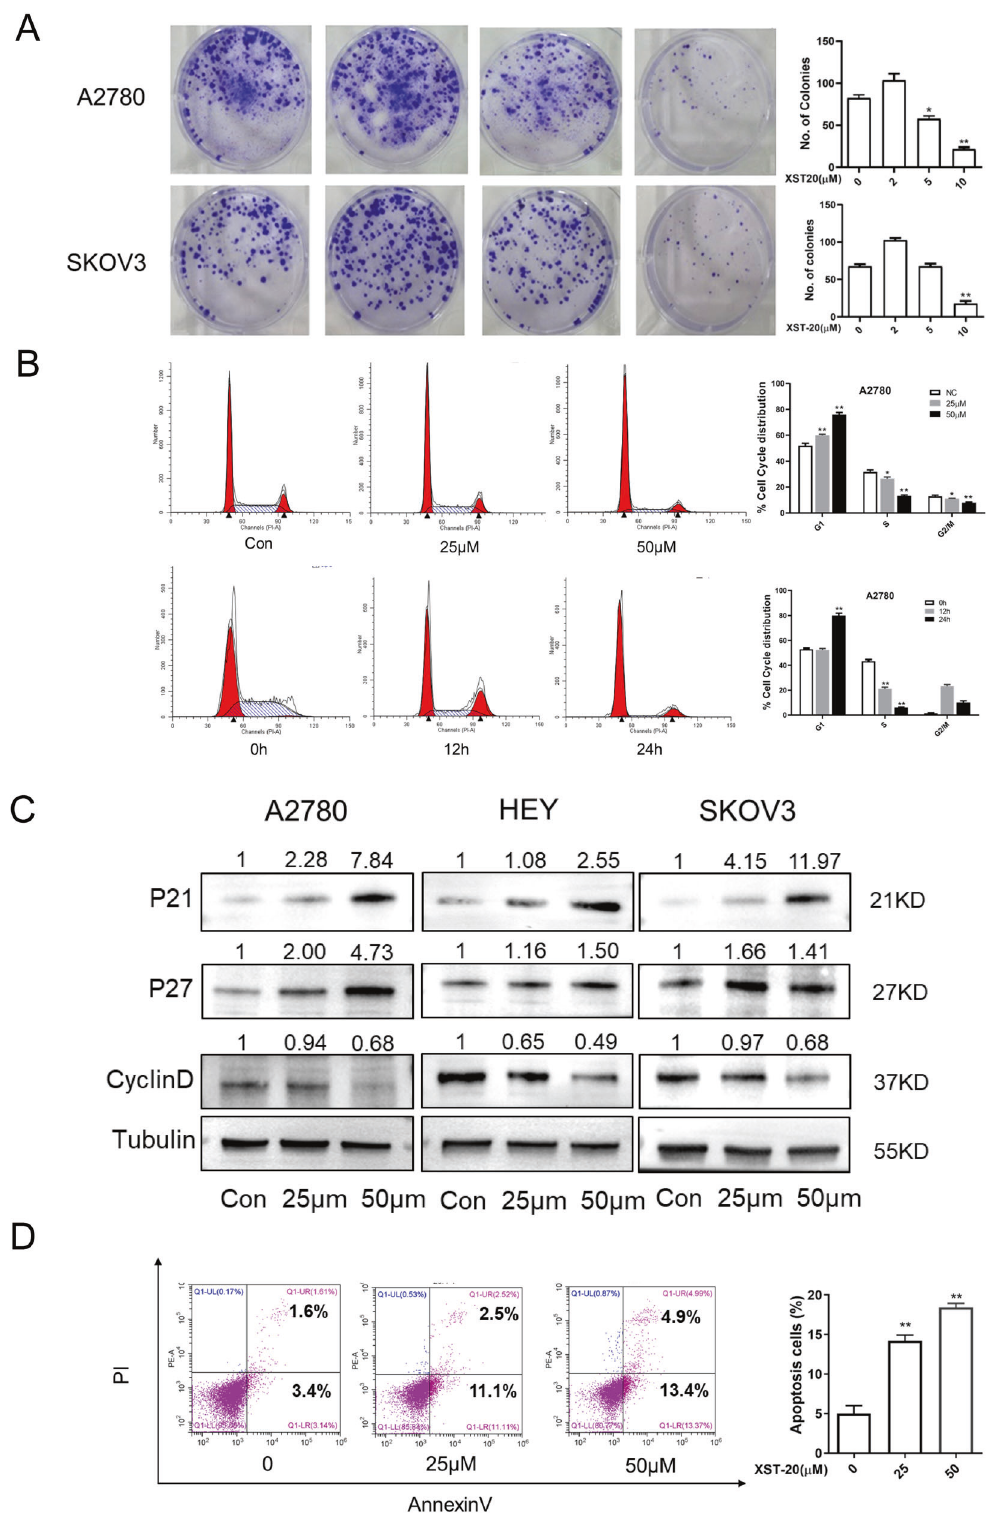
Fig. 5 XST-20 exhibits an anti-tumor effect in ovarian cancer cells. A Clonogenic assay were conducted to measure the inhibitor effect of XST-20 on ovarian cancer cells. B Cell cycle distribution was examined by fl ow cytometry in A2780 cells treated with XST-20. C Proteins that are involved in the regulation of G1/S progression were analyzed by western blot in A2780, HEY, and SKOV3 cells treated with XST-20. D A2780 cells were treated with XST-20 and apoptosis was measured by fl ow cytometry with annexin V staining. Data were presented as means ± S.D. * p < 0.05, ** p < 0.01 compared with the control